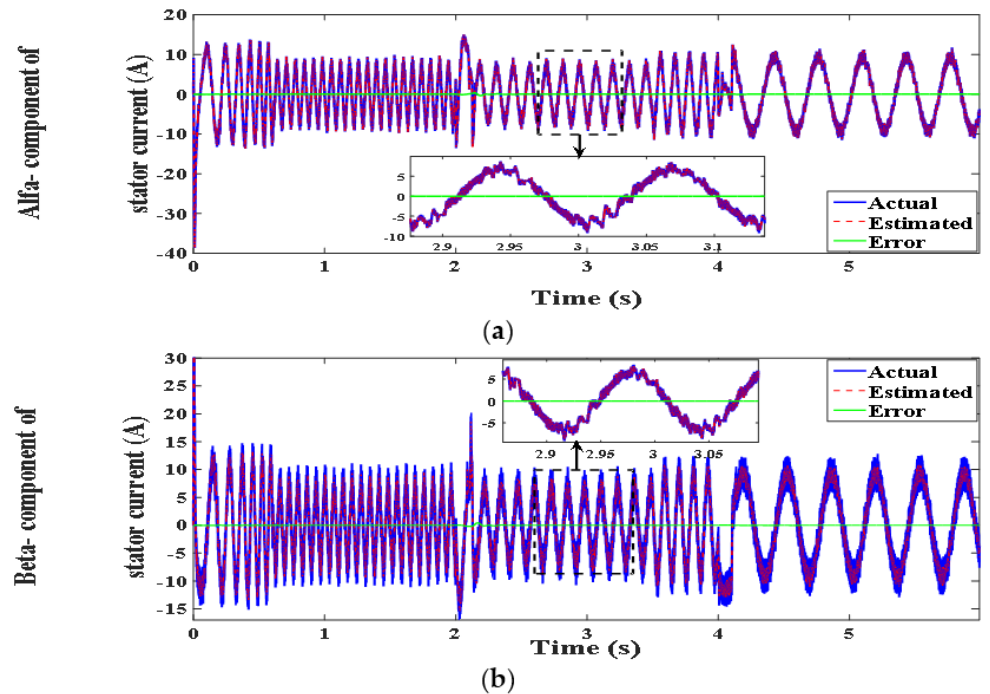
Figure 12. ( a ). Alfa-component of stator current under PTC approach (A), ( b ). Beta-component of stator current under PTC approach (A).